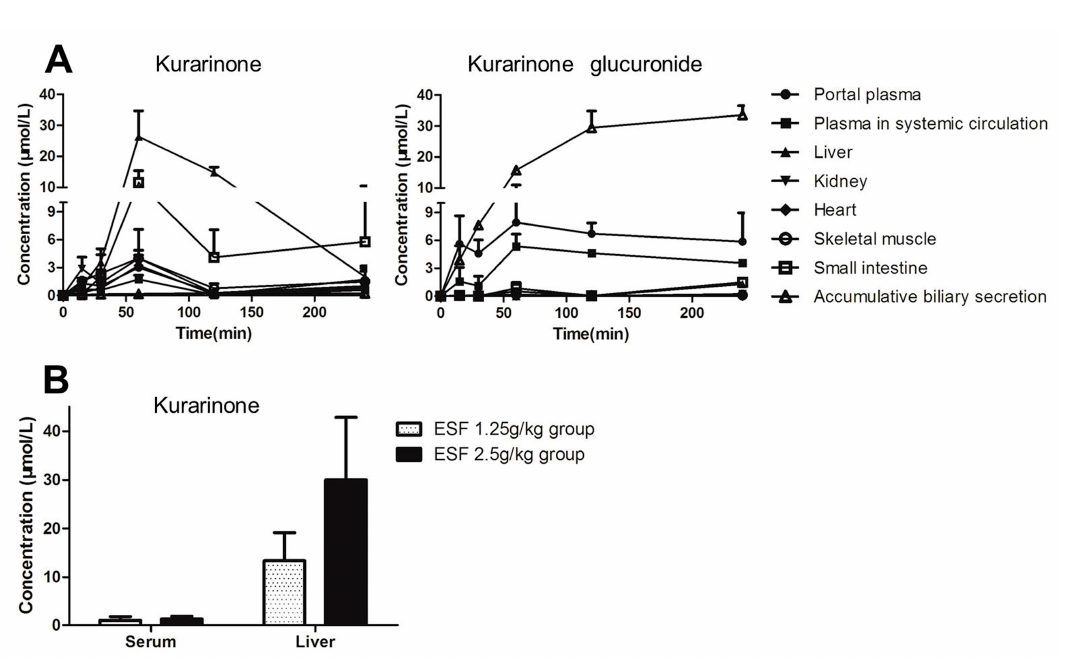
Figure 8. Kurarinone and kurarinone glucuronide levels in fluids and tissues of rats dosed with extract of Sophora flavescens (ESF). ( A ) Tissue distribution of kurarinone and kurarinone glucuronide after oral administration of ESF (2.5 g/kg) in rats (mean ± S.D., n = 3); ( B ) Kurarinone levels in serum and liver of ESF-treated rats for 2 weeks (mean ± S.D., n = 6). Table 2. Tissue AUC 0–4h values of kurarinone and kurarinone glucuronide after oral administration of ESF (2.5 g/kg) in rats (mean ± S.D., n = 3).